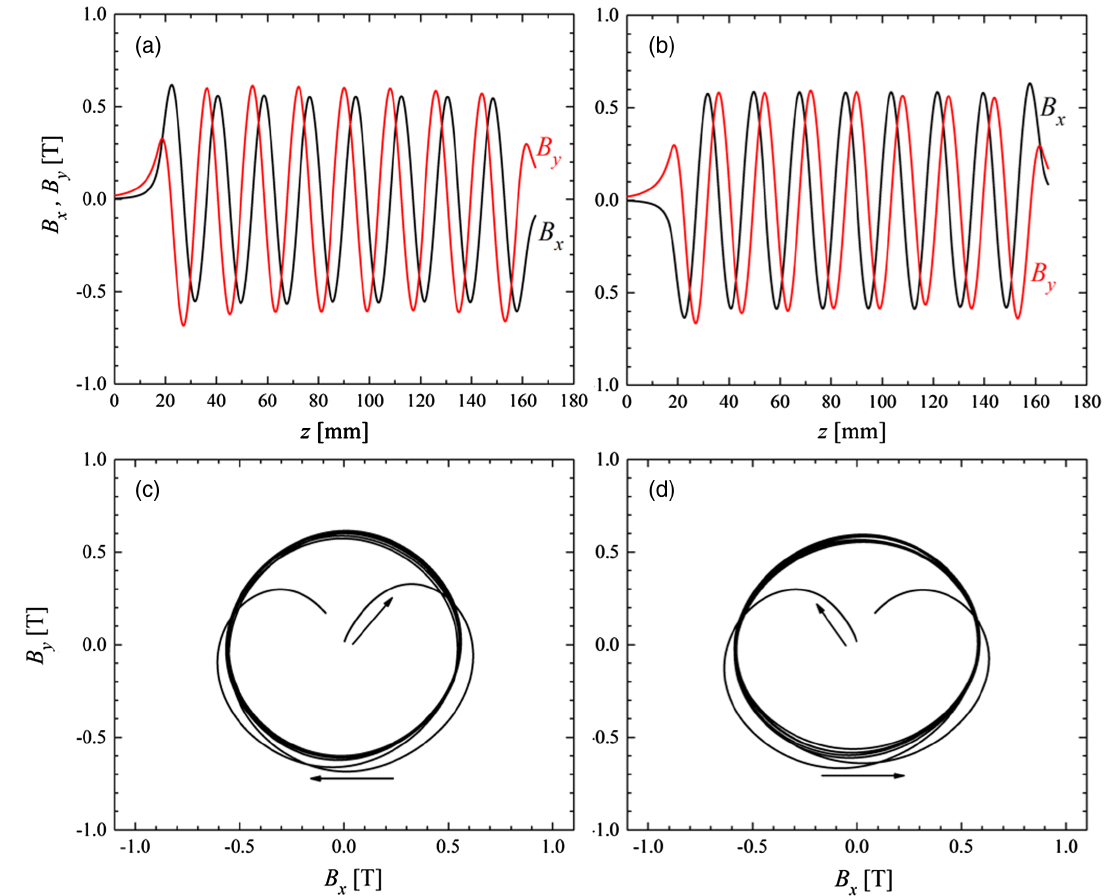
10. Results of the field measurement: field distributions along the (a) RCP and (b) LCP axes, and their parametric plots (c) and (d), respectively.